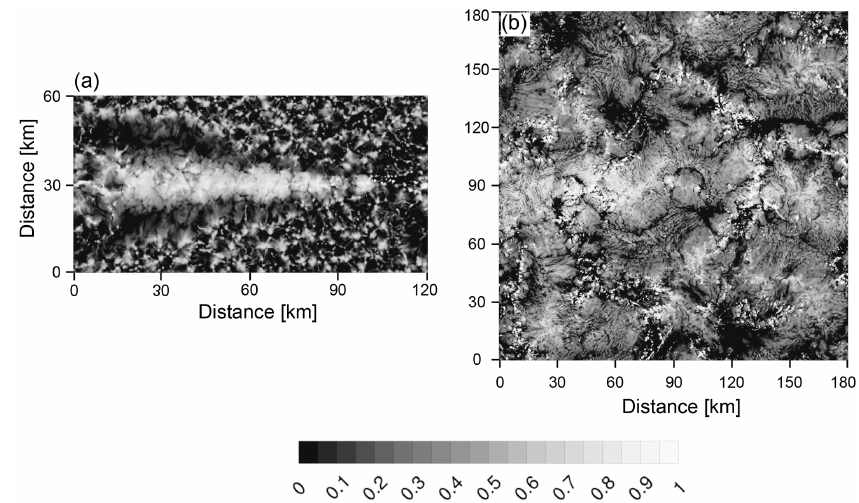
Figure 5. (a) Cloud albedo field from Fig. 1a in Wang et al. (2011) for an 800m deep boundary layer. (b) Cloud albedo at 12:00UTC on the second day of the ship simulation for a 1.5km deep boundary layer. Both simulations were subject to an equal seeding source of 10 17 particless − 1